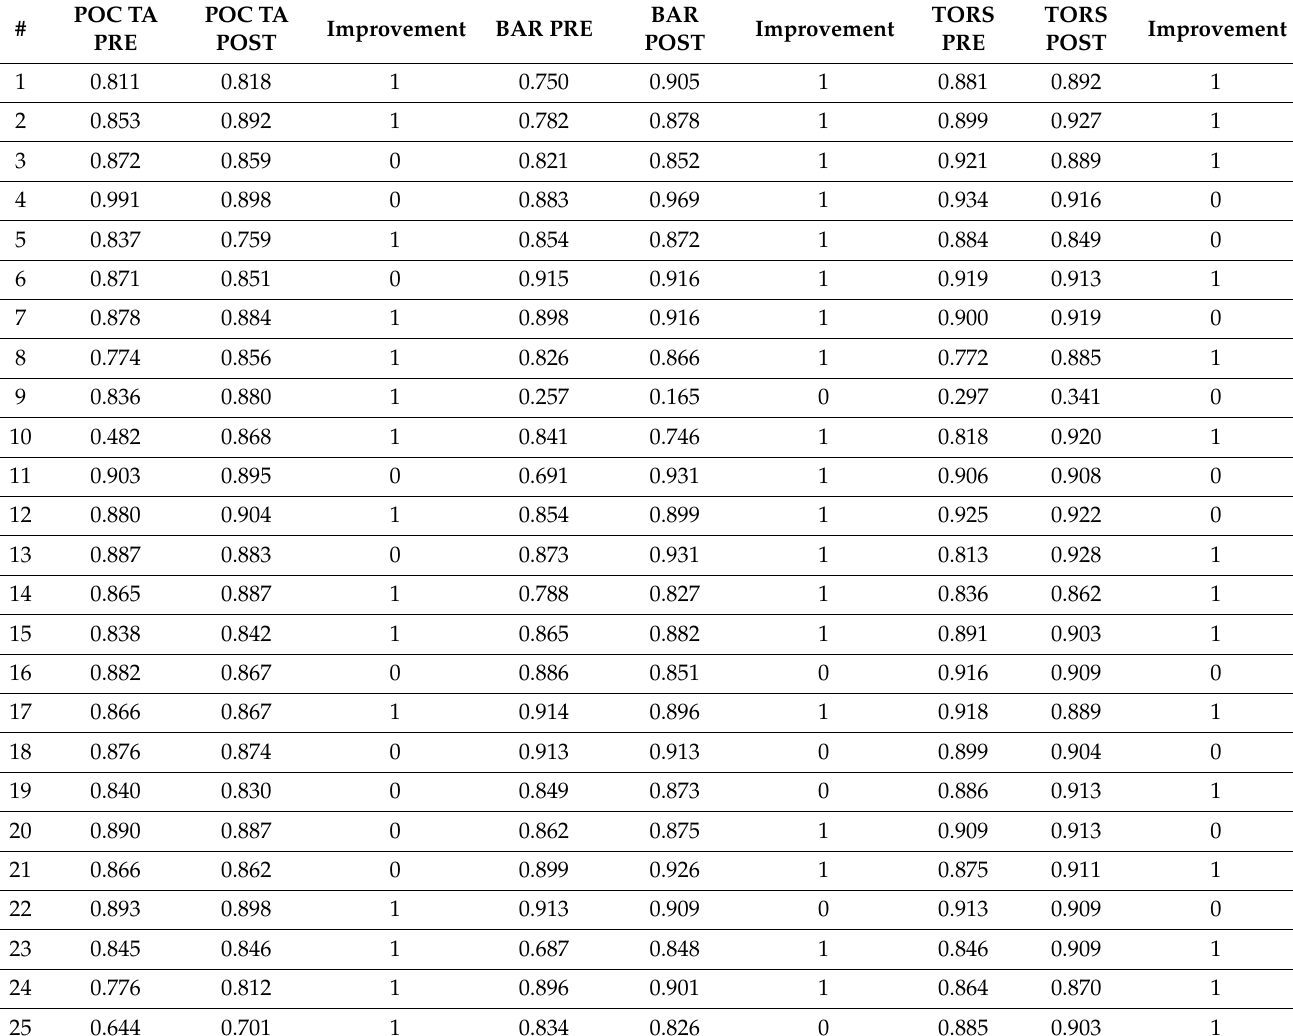
Table 2. PRE and POST treatment